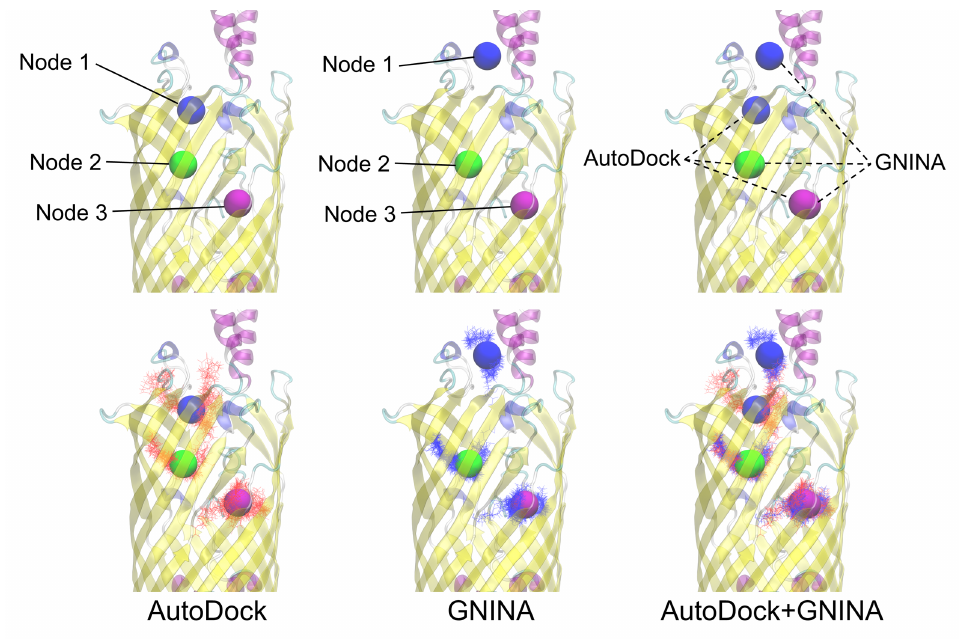
Figure 4. Nodal locations for AutoDock and GNINA. The nodes are labeled ( top ) and the ligands are represented for AutoDock (red) and GNINA (blue) in lines ( bottom ). Both sets of dockings appear to find the important nodes of the S3 kink and the high and low affinity binding sites. GNINA’s docking did reveal a preference for the dockings to be located closer to the extracellular space than AutoDocks, but the C8E4’s binding from experimentation are still in close